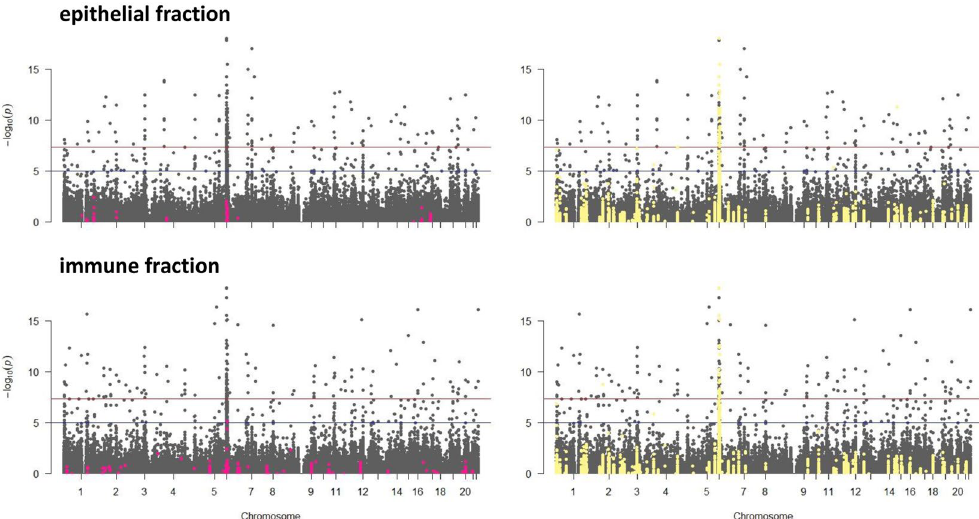
Figure 6. mQTLs and their overlap with differential methylation and genetic association in CD. Manhattan plot of the p values of the putative cis- mQTLs identified in epithelial (top) and immune (bottom) cells. mQTL- SNPs that correlated with individual DMPs are shown in pink (none of the DMP-correlated SNPs reached genome-wide significance in the putative cis -mQTLs in which they participated). In turn, SNPs associated to CD according to the Immunochip project 1,39 are highlighted in yellow, and consequently, mark those mQTLs that overlap CD-associated variants, many of which are genome-wide